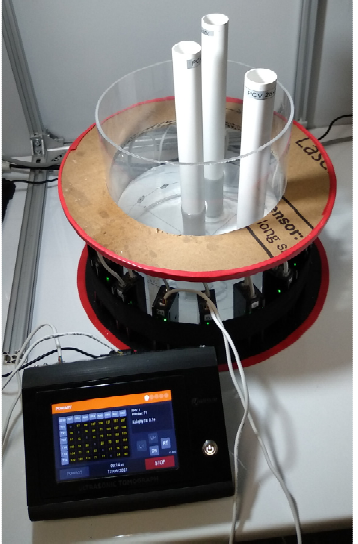
Figure 5. Measurement system for ultrasound tomography.